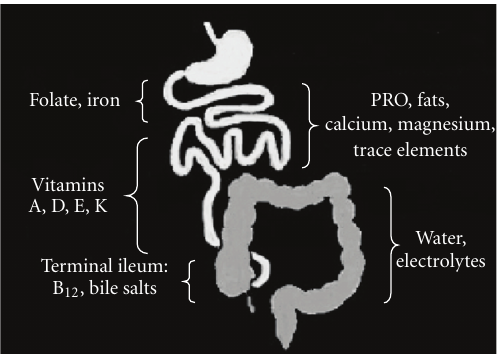
Figure 1: Primary sites of absorption of nutrients essential for bone